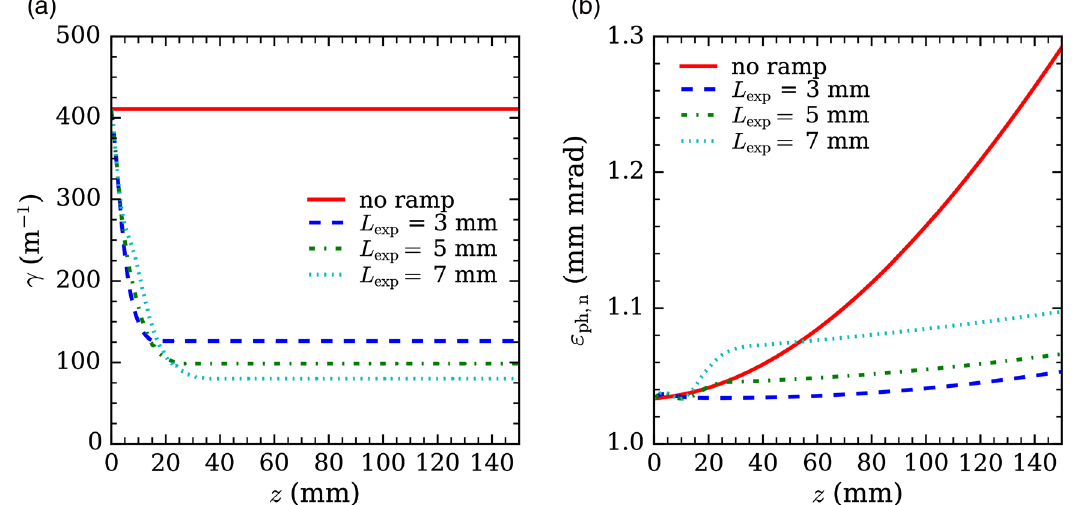
FIG. 4. Evolution of Twiss parameter γ (a) and normalized phase emittance ε drift, for the exponential density profiles with L ¼ 3 , 5, and 7 mm, compared to the case without a ramp. z ¼ 0 mm is the down ramp